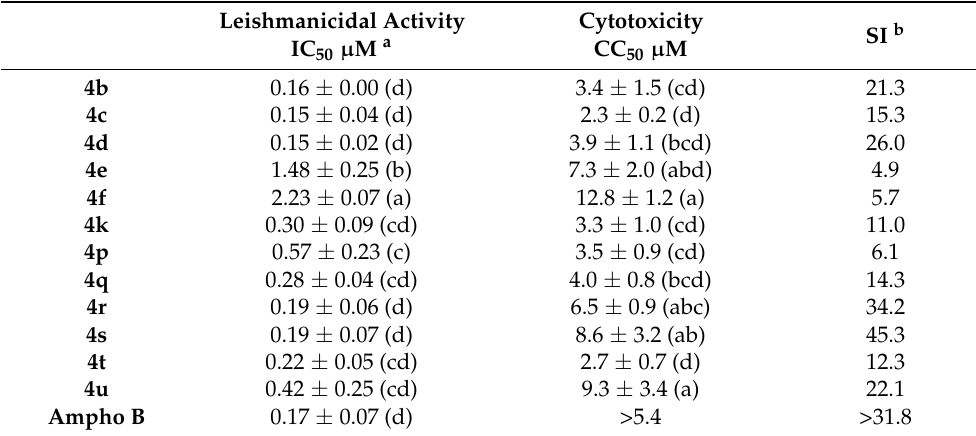
Table 3. Inhibitory activity of bis(spiropyrazolone)cyclopropanes 4 against promastigotes of L. mexicana and cytotoxicity in RAW cells and selective